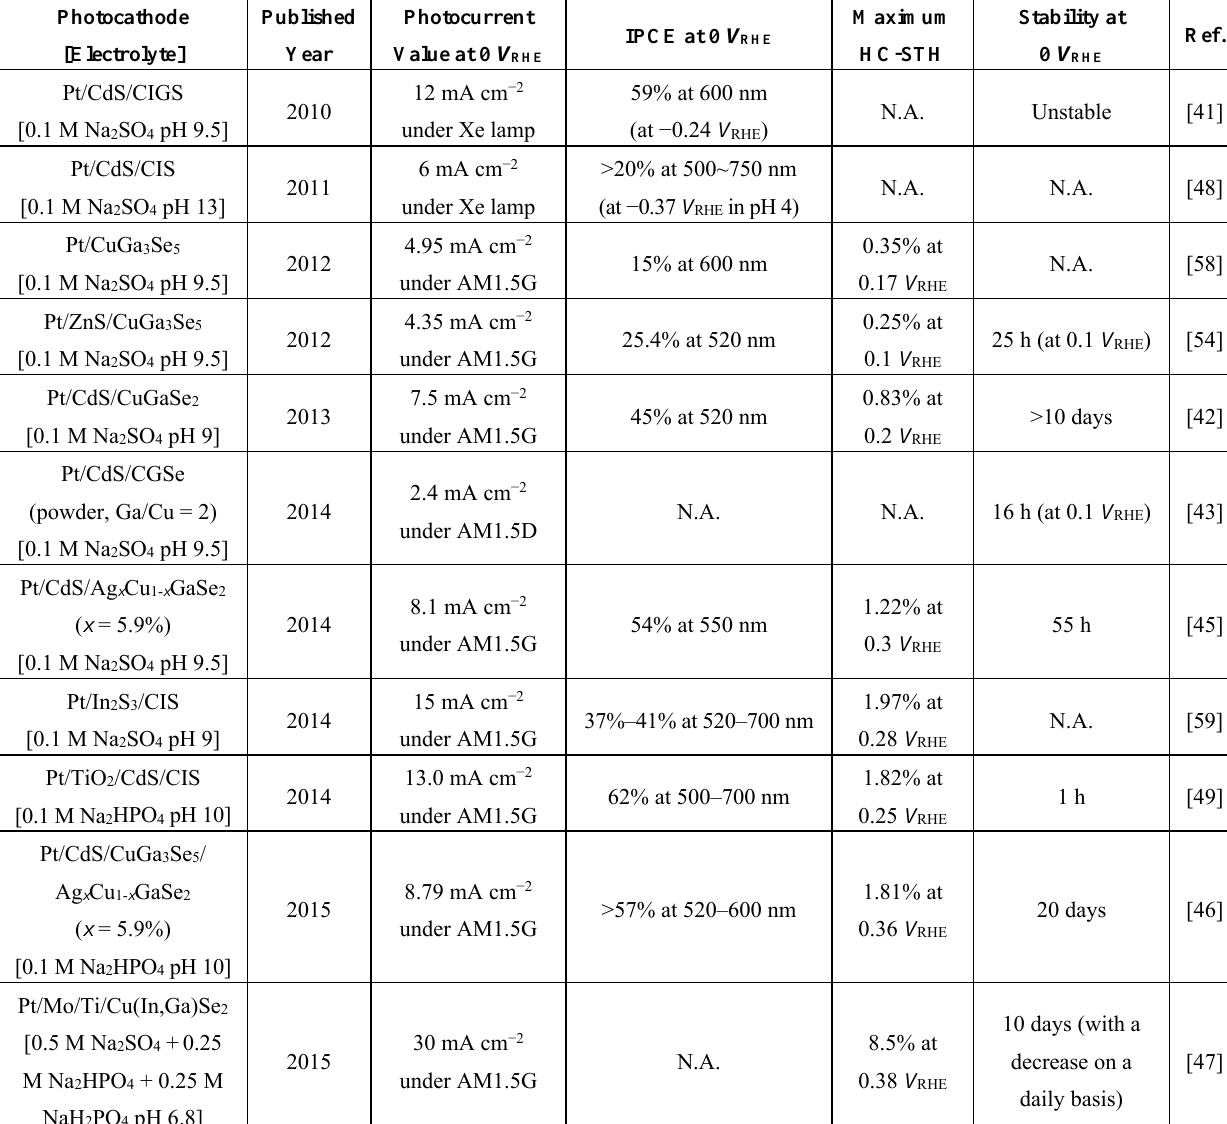
Table 1. Reported PEC properties of copper chalcopyrite